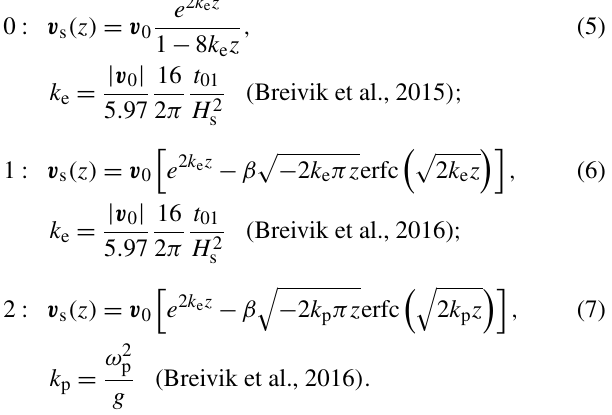
Figure 2c, f and i also show a summer and winter spatial distribution of the surface Stokes drift velocity and its vari- ability with wind